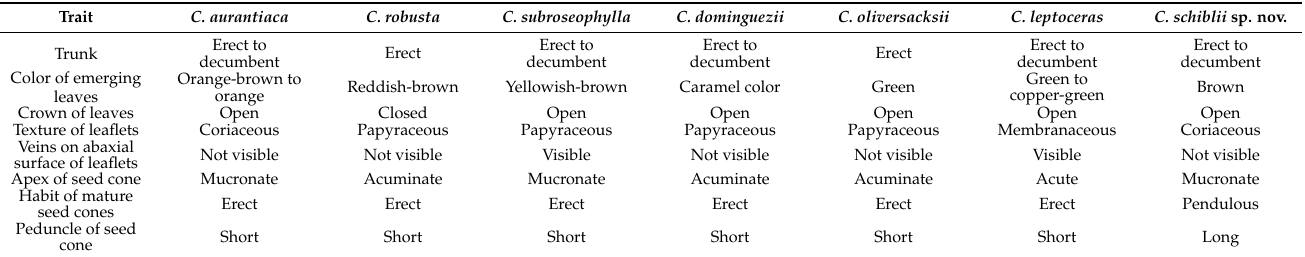
Table 2. Comparison of morphological variation among species of the Ceratozamia robusta species complex.